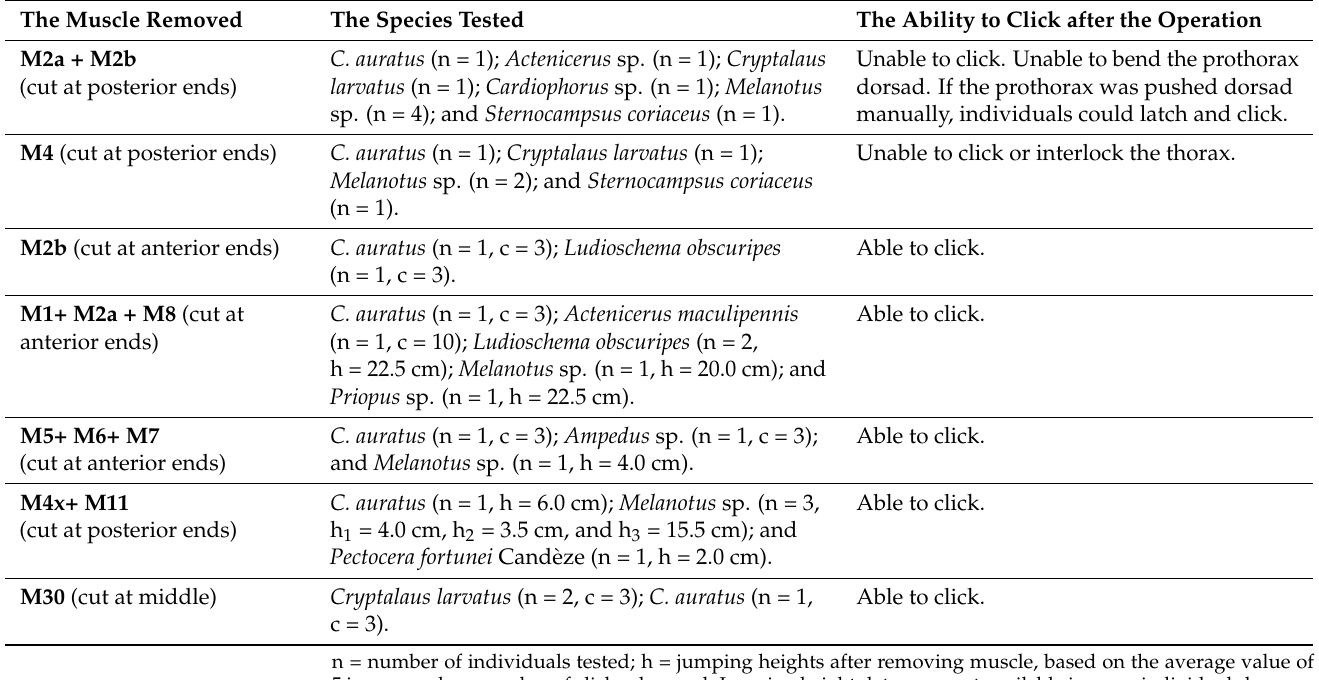
Table 2. The influence of removing the thoracic muscles on the clicking mechanism in Elateridae.